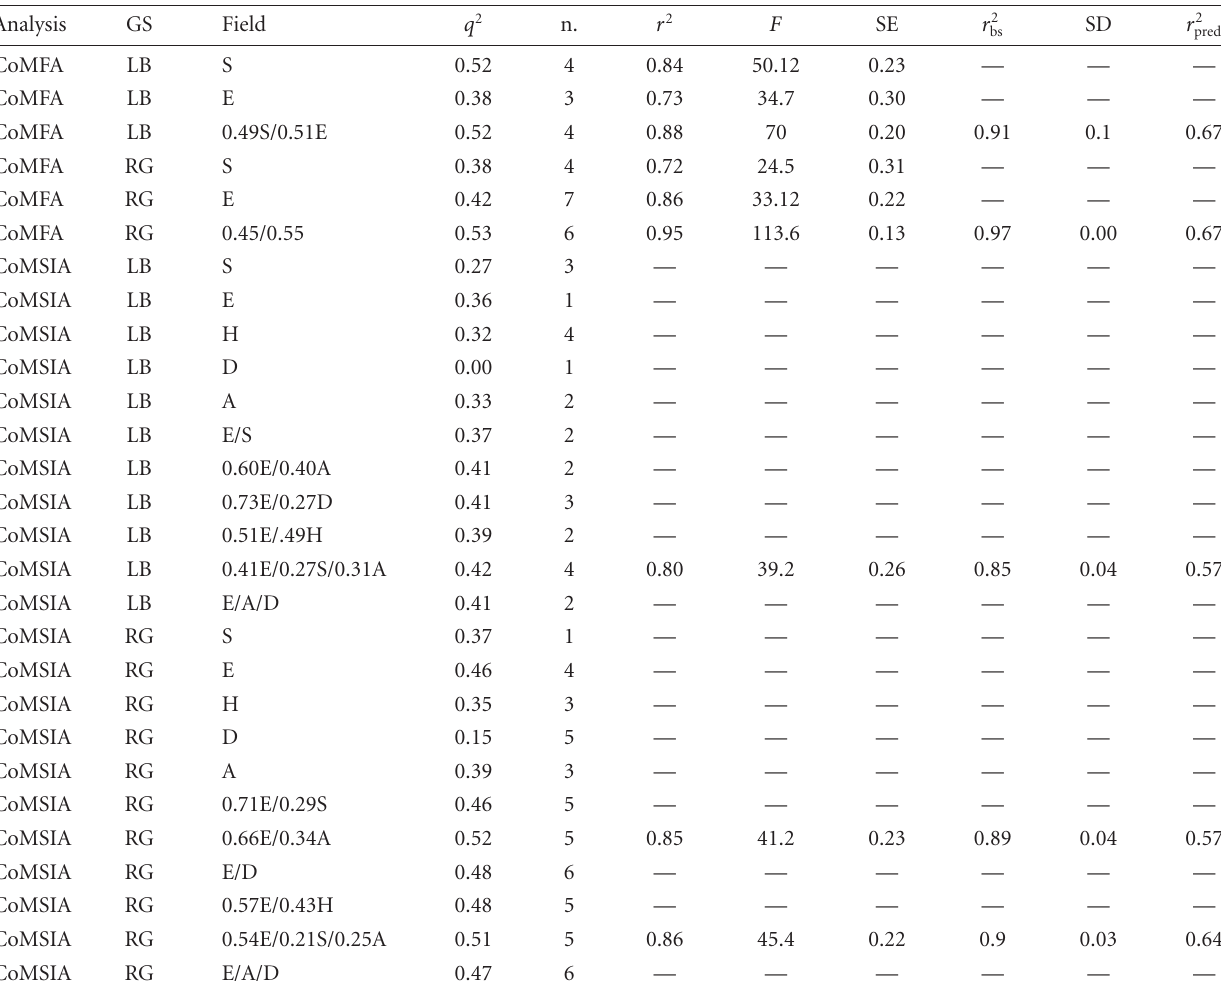
Table 2: Statistical summary of di ff erent PLS analysis. (GS: geometrical scheme; SE: standard error of estimate; n.: number of components; F : Fischer’s F value for test of significance; r 2 : coe ffi cient of determination after 100 bootstrapping runs; SD: standard deviation; Field bs contribution: (S) steric field, (E) electrostatic field, (H) hydrophobic field, (D) H-bond donor field, and (A) H-bond acceptor field.).